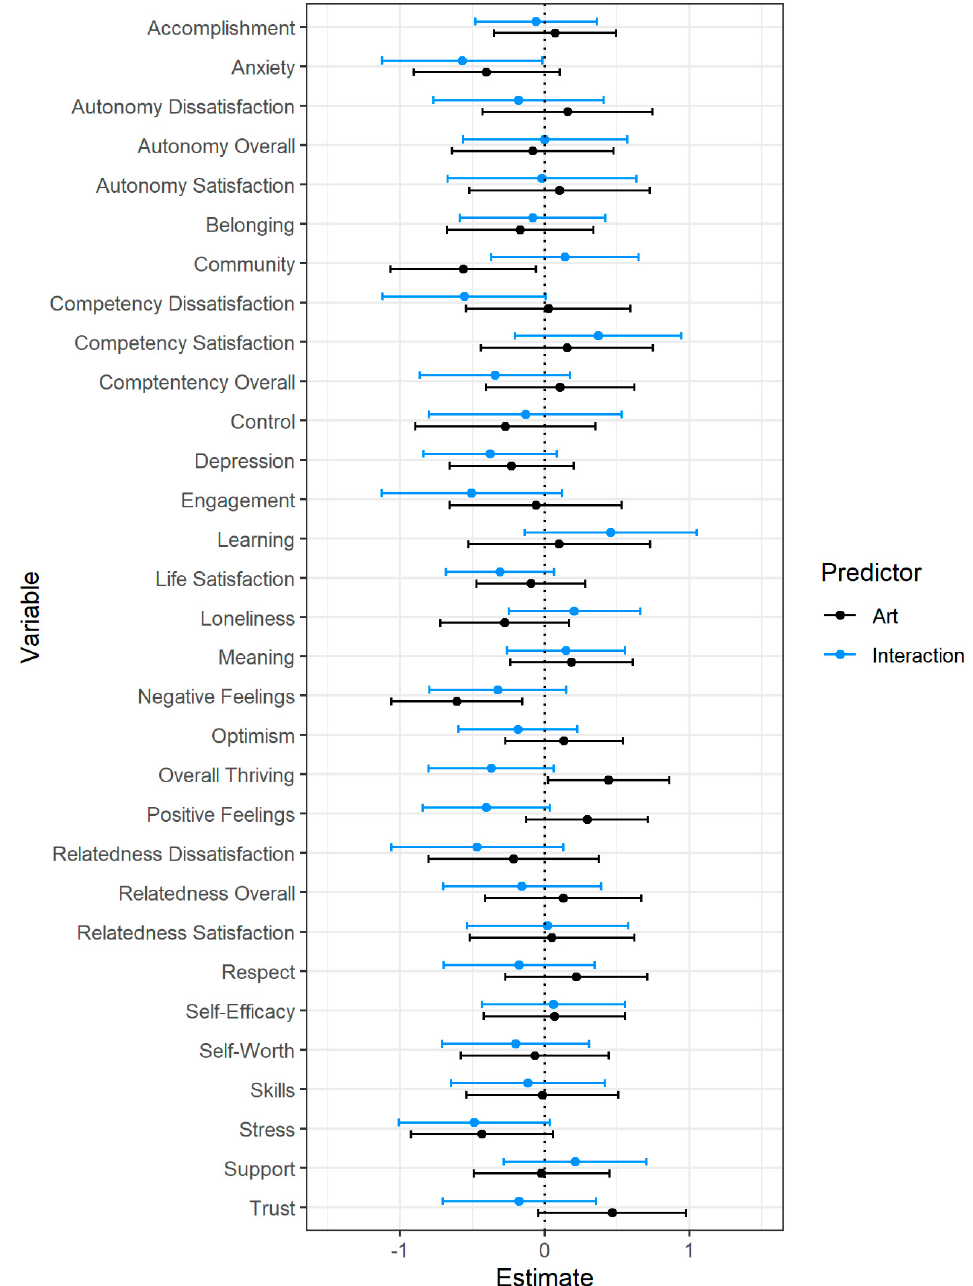
Figure 5. Latent art topic factor and interaction predicting post-intervention well-being. Note. Esti- mates represent regression weights (controlling for pre-intervention well-being) in pre-intervention standard deviation units. Error bars represent 95% confidence intervals.